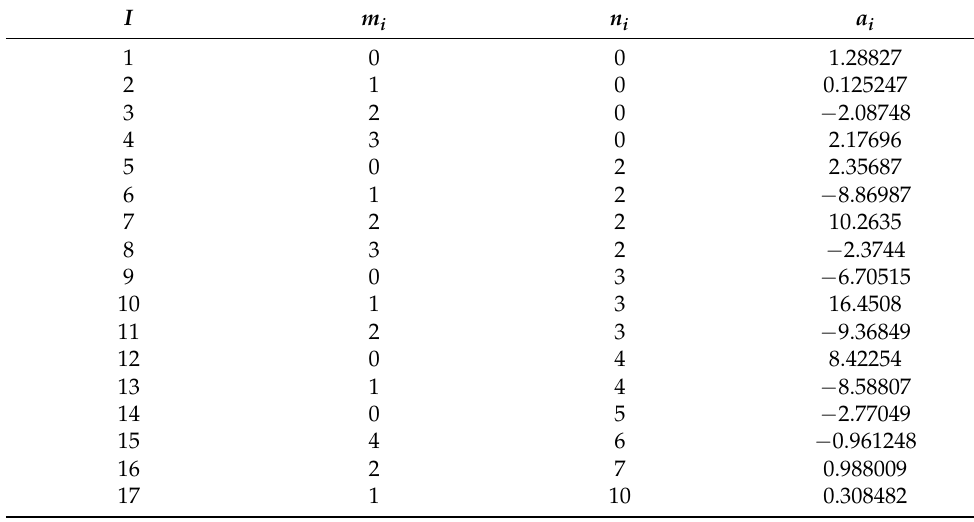
Table A5. Coefficients for Equation (A39)